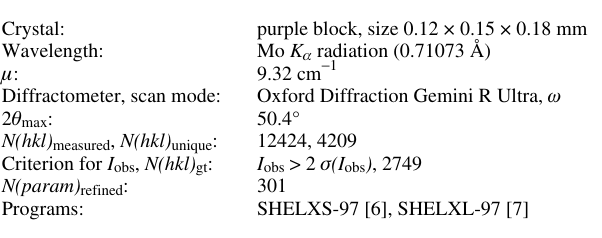
Table 1. Data collection and handling.